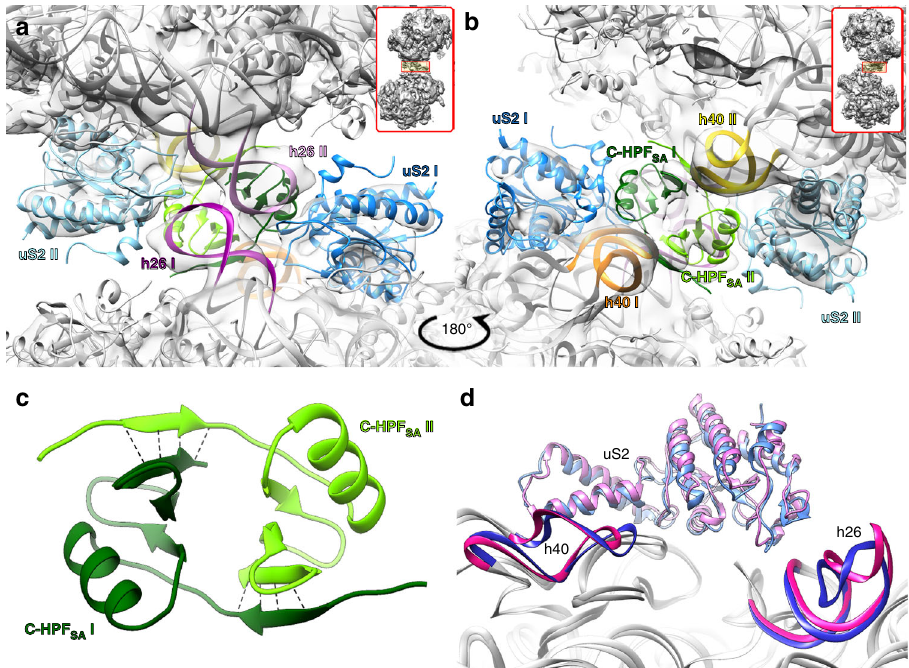
Fig. 3 Close-up view of interface between the two 30S subunits. a h26 of the top ribosome ( pink ) is interacting with uS2 of the bottom ribosome ( blue ) and vice versa (h26 in magenta and uS2 in light blue ). b h40 of the top ribosome ( yellow ) is interacting with C terminal HPF SA (C-HPF SA ) of the bottom ribosome ( dark green ) and vice versa (h40 in orange and the C-HPF SA in light green ). View of the whole 100S and the interface region within the 100S structure of both a and b is shown in the upper inset. c Homology model of the C-HPF SA suggests the two domains self-dimerized via β -sheet interactions. d Superposition of SA100S and S. aureus 70S (SA70S PDB code 5LI0). Helices 26 and 40 are in blue and hot pink , respectively. Ribosomal protein uS2 of SA100S is in light blue , uS2 of SA70S is in light pink , and the rRNA of both structures is in